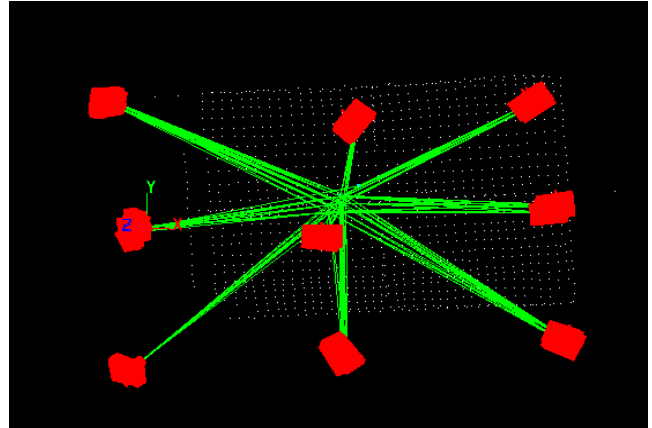
Figure 8. Camera calibration station’s distribution map.